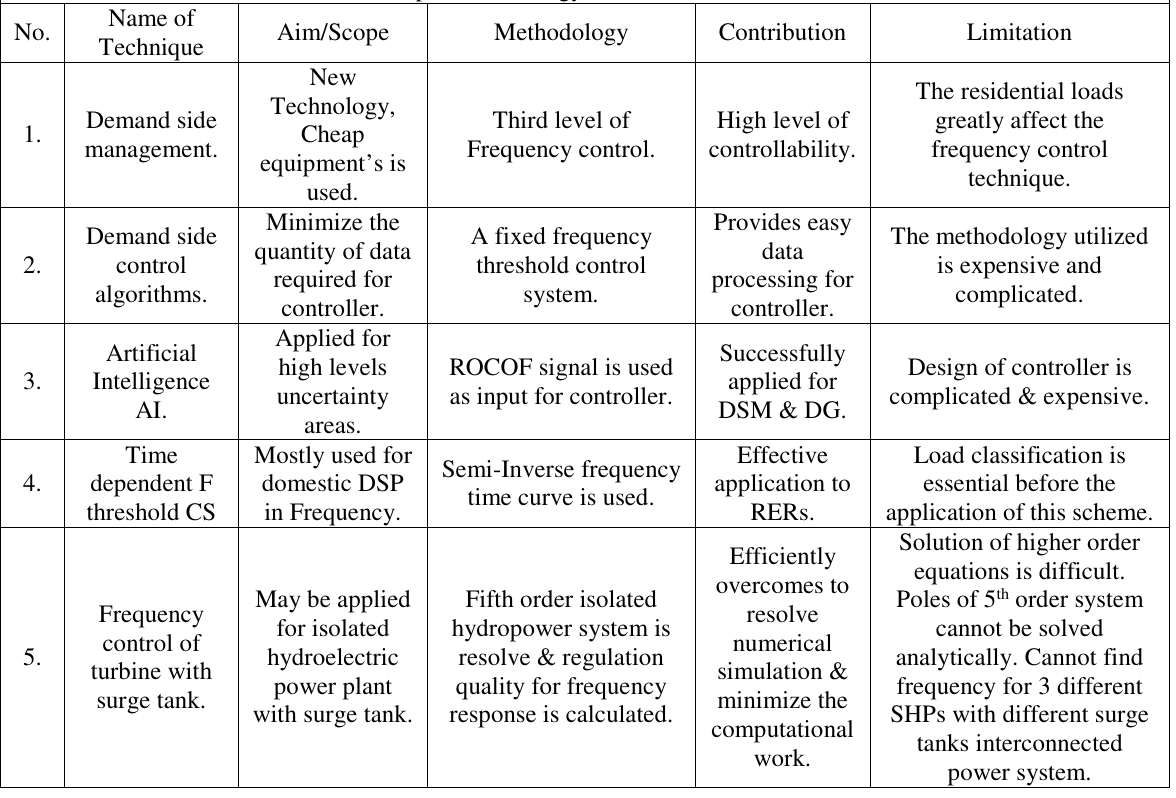
Table 1: Name, aim and scope, methodology, contribution and limitations of each scheme.